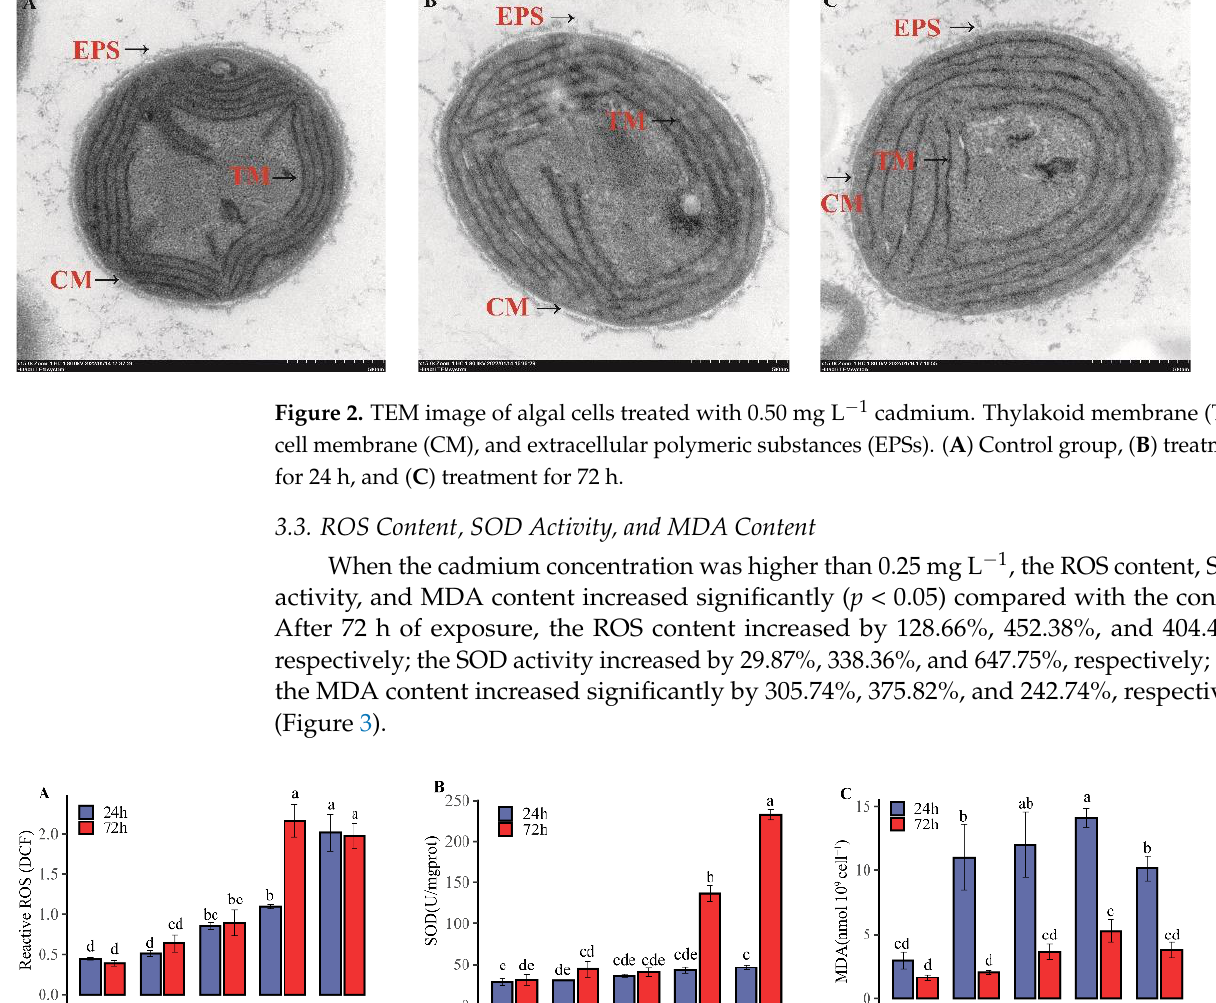
Figure 4. Algal cells were treated with cadmium at different concentrations for 24 h and 72 h. ( A ) Chlorophyll a content. ( B ) F v /F m. According to the one-way ANOVA test, different alphabet letters indicate a significant difference in different treatment groups at p < 0.05. ( C ) Treatment time of Q A − reoxidation kinetics of different concentrations of cadmium was 72 h.